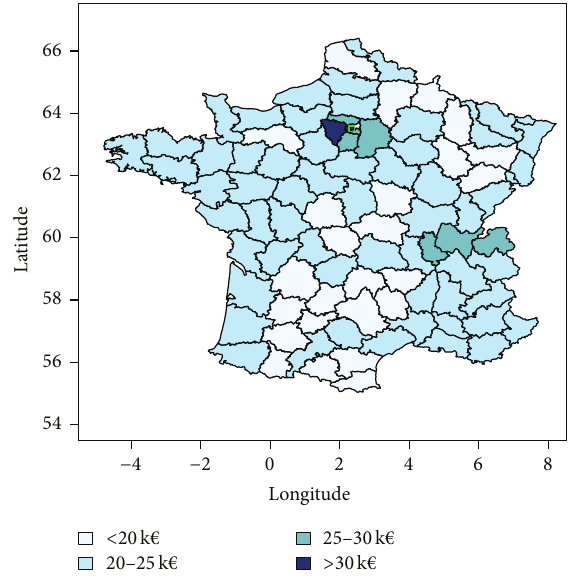
Figure 1: Median